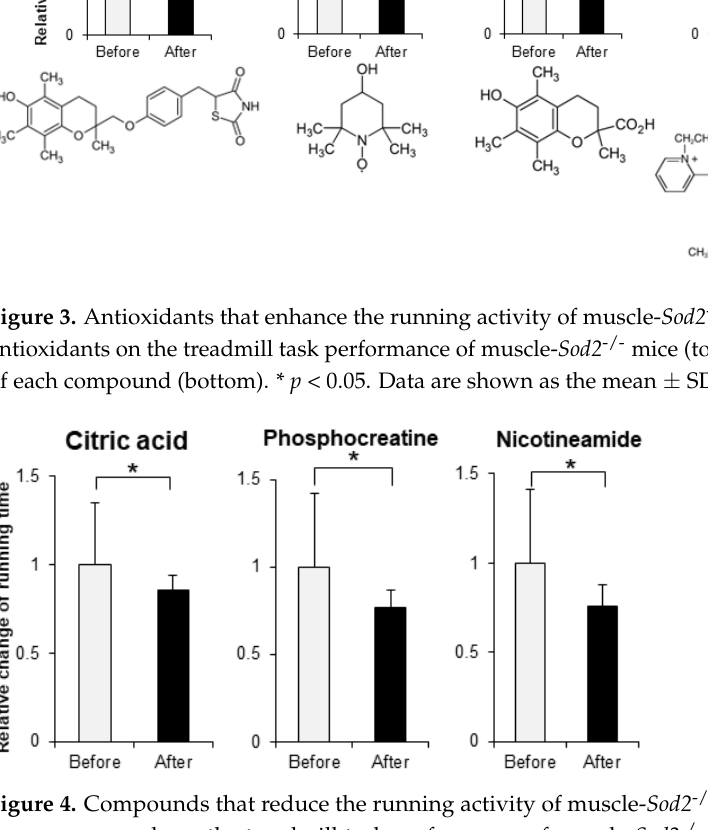
Figure 4. Compounds that reduce the running activity of muscle- Sod2 -/- mice. Negative effects of some compounds on the treadmill task performance of muscle- Sod2 -/- mice. * p < 0.05. Data are shown as the mean ± SD.